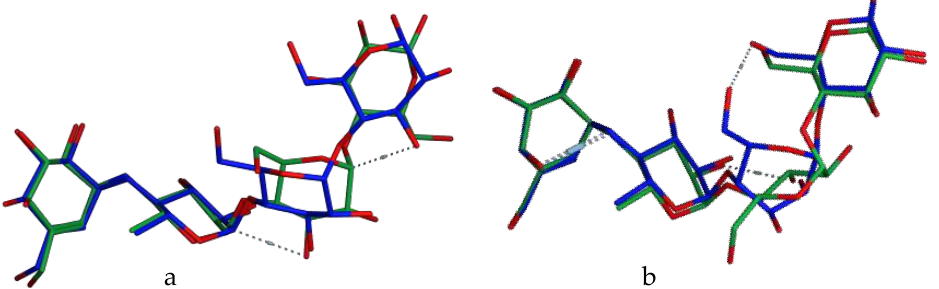
Figure 2. Superposed structures of acarbose after validation of the binding mode as obtained using the MOE software: in blue, the crystallographic pose; in green, the top-ranked docking pose. ( a ) α - glucosidase (PDB ID: 2QMJ); ( b ) α -Amylase (PDB ID: 7TAA). Table 1. Inhibition modes and inhibition constant ( K i ) values obtained from Lineweaver–Burk plots and Dixon Plots, respectively, for metabolites of Z. chalybeum against α -glucosidase and α -amylase inhibition in comparison to the reference acarbose inhibitions.